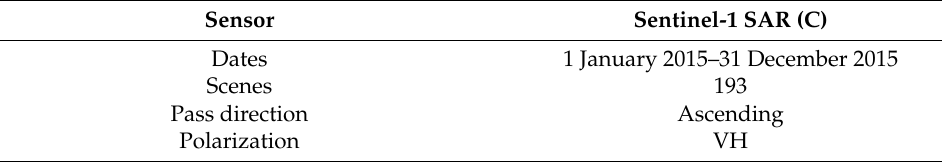
Figure 1. Geographic location of the study area. Table 1. Sentinel-1 GRD IW image data.